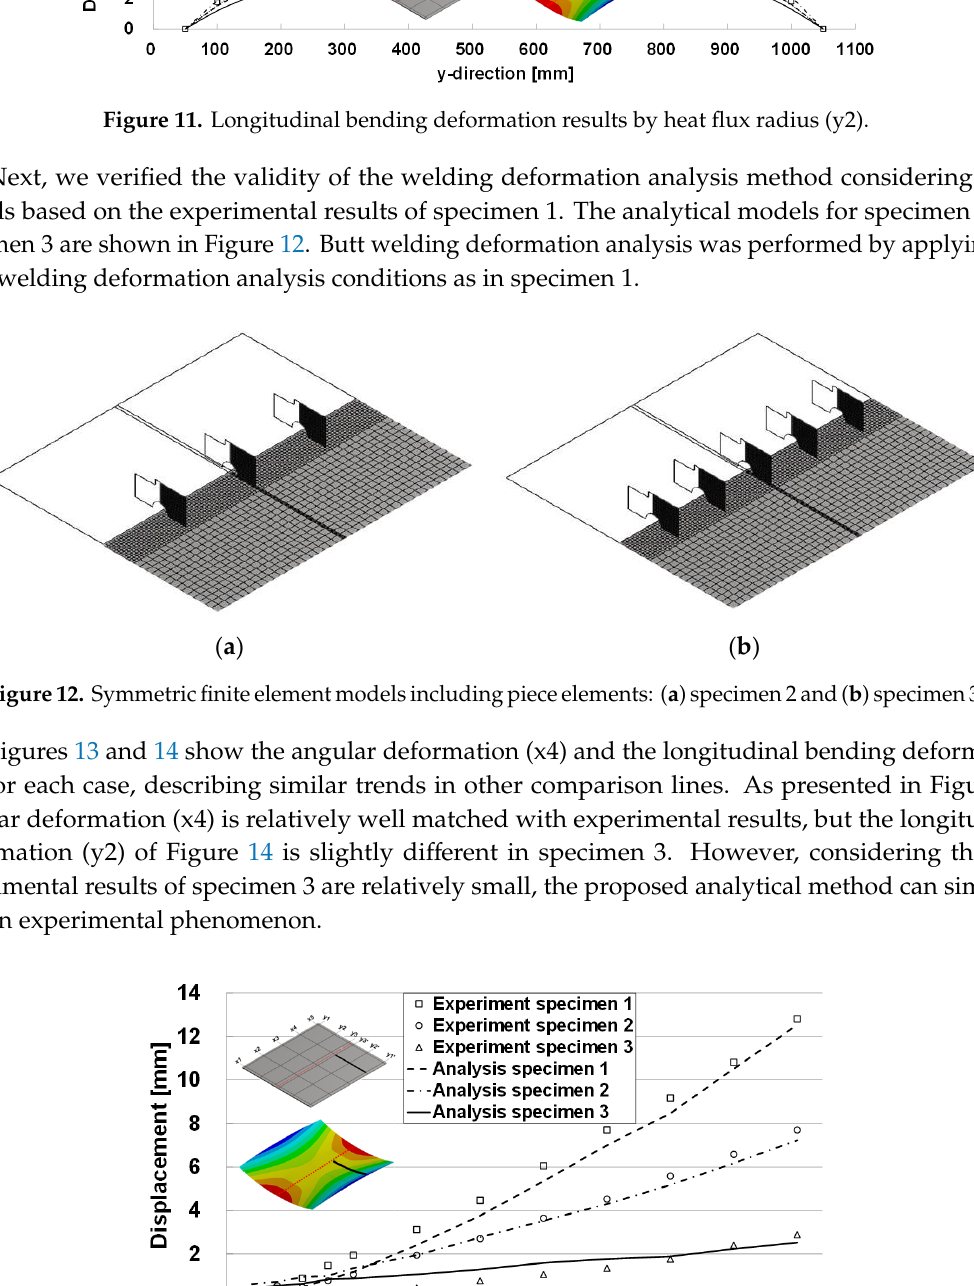
Figure 11. Longitudinal bending deformation results by heat flux radius (y2).